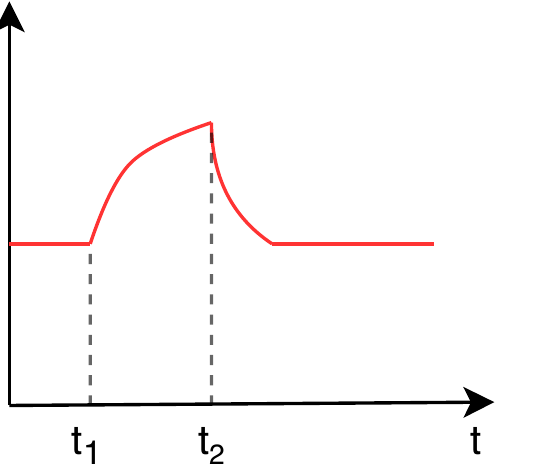
Figure 6. Behavior of velocity (V) and differential pressure ( ∆ P ) with respect to time (t) in the presence of a velocity excursion. Differential pressure acting on the